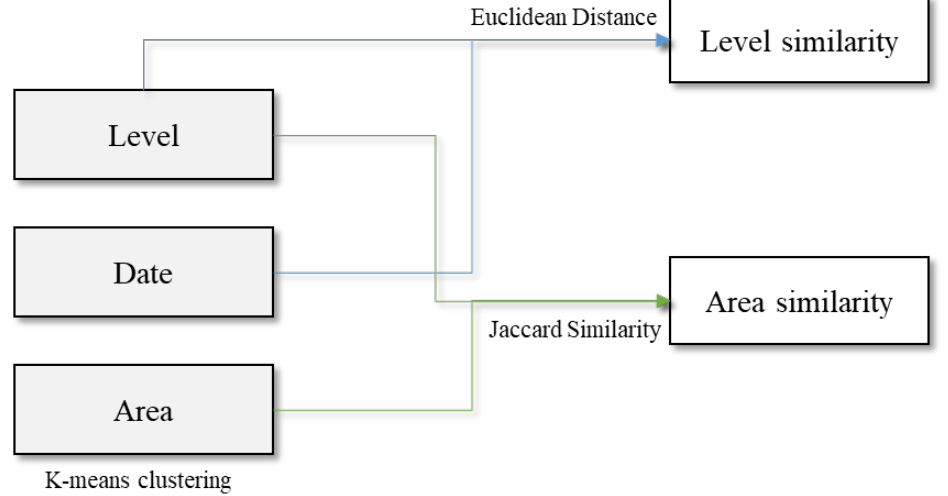
Figure 3. Used features of data and